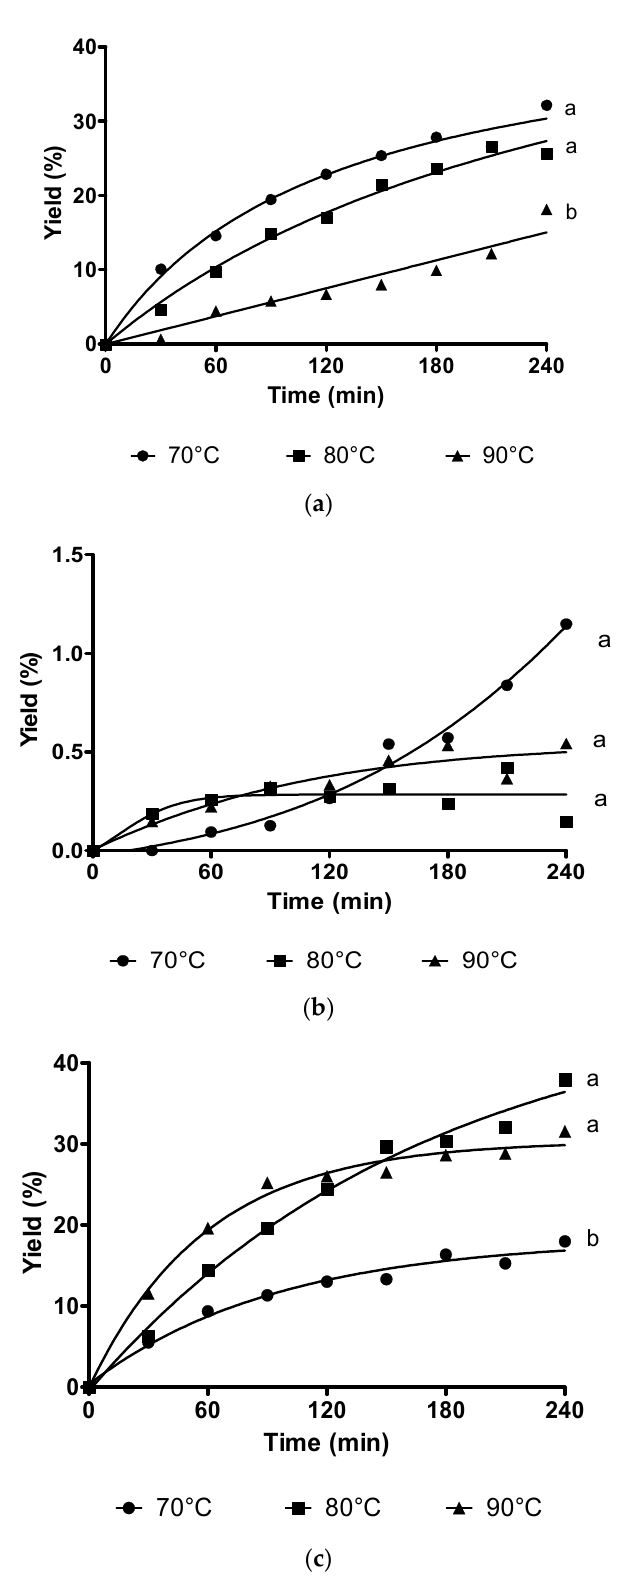
Figure 1. The experimental data of solvent-free 7- O -kojic acid monopalmitate synthesis in stirred tank reactor (STR) for 240 min using RMIM ( a ), TLIM ( b ) and Novozyme 435 ( c ) at 70 °C, 80 °C, and 90 °C. Data are presented as means ± S.E.M, n = 3. The letters a and b indicate significant difference at p < 0.05 with Bonferroni’s Multiple Comparison Test.